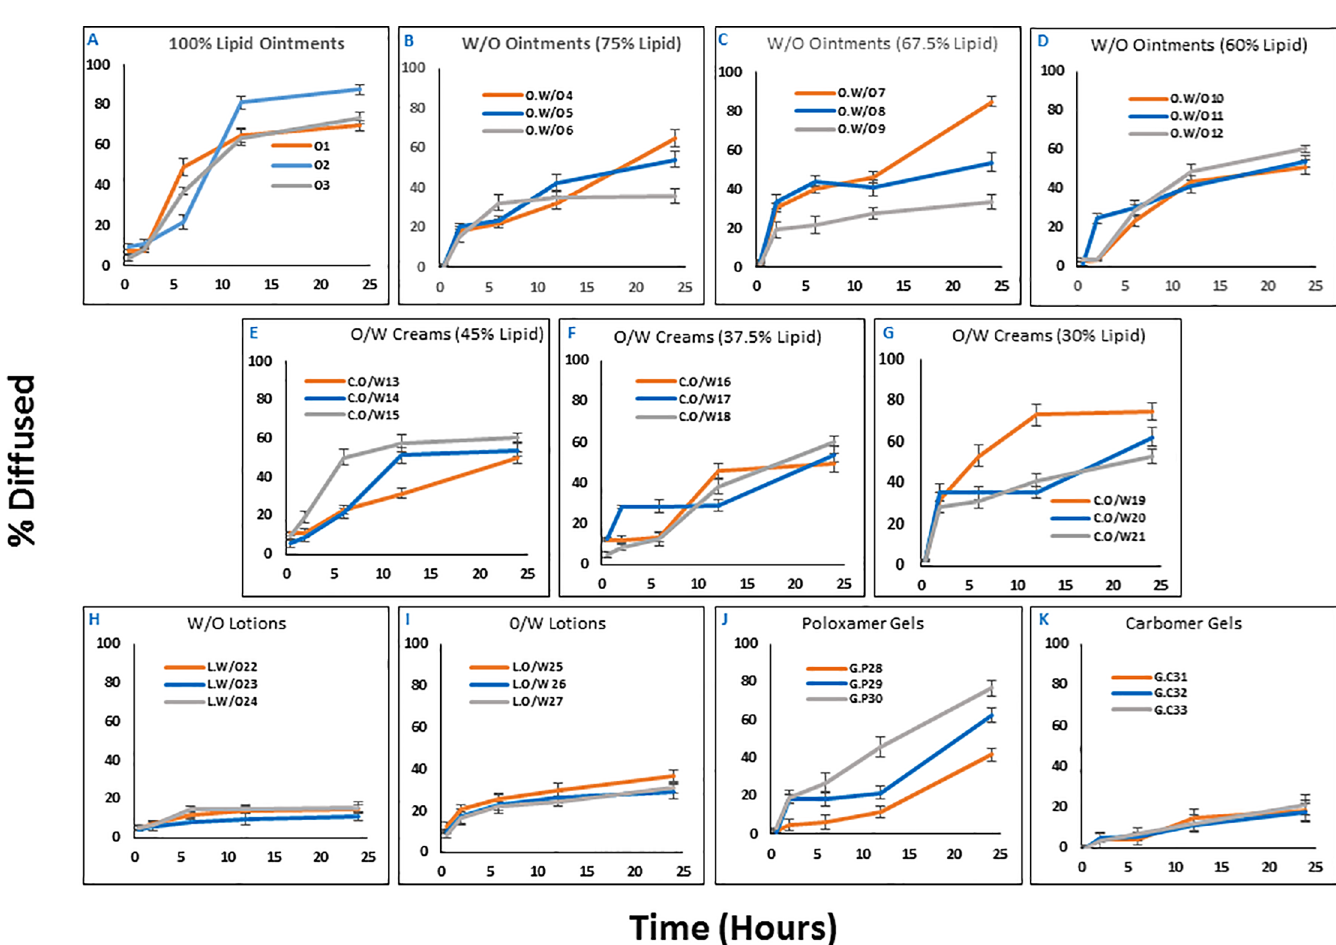
Fig 1. Transmembrane diffusion. The in vitro transmembrane diffusion profile of the formulation library using Franz cells. Each panel represent a set of three formulations that shared similar phase composition and lipid content, but differed in surfactant system (n = 3; error bars indicate standard deviation).